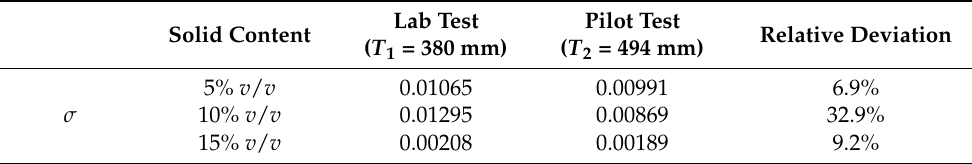
Table 10. The solid uniformity σ before and after scaling up based on the same unit volume power.